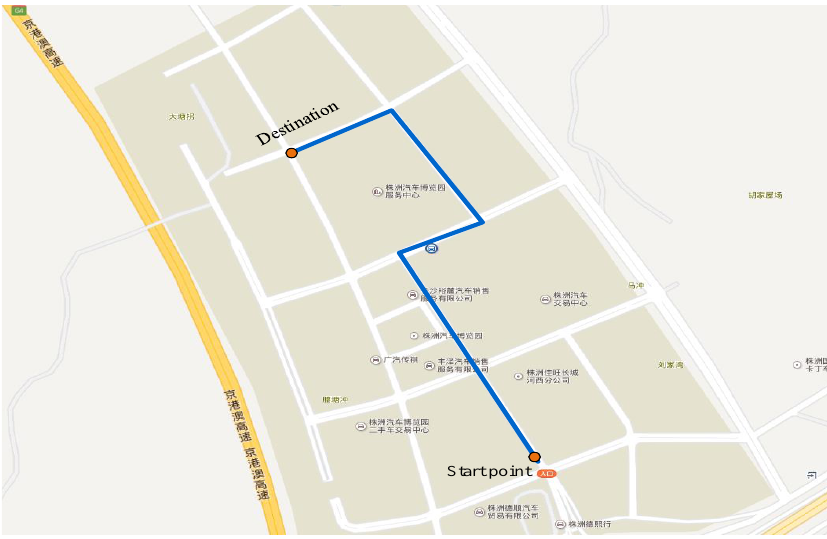
Figure 15. Travel route of field test.